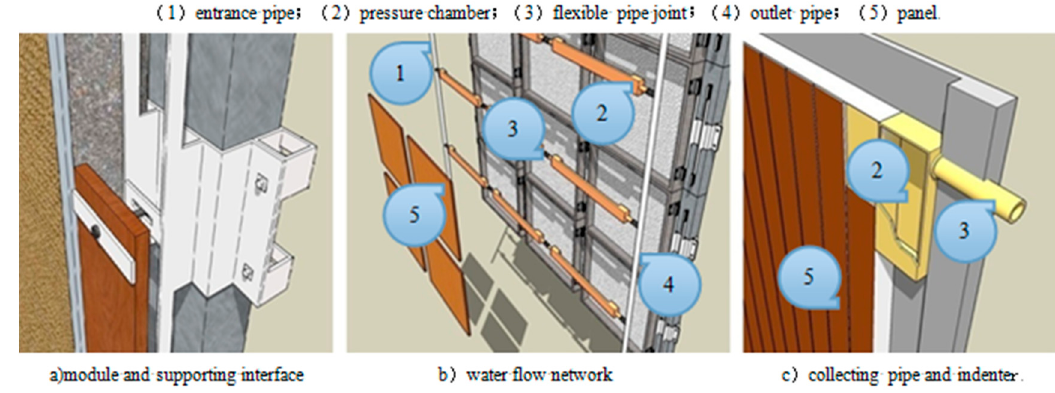
Figure 4. Interior water supply network.